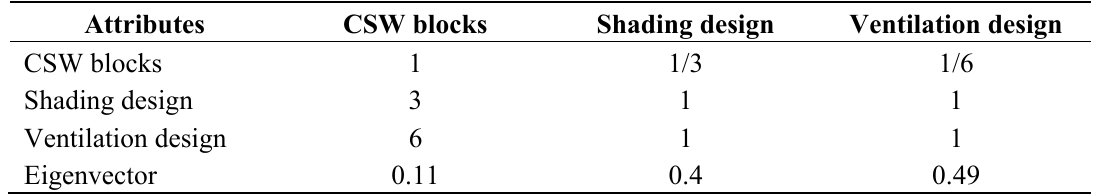
Table 2. Weighting value of interior design: comparison of CSW blocks, shading design, and ventilation design.